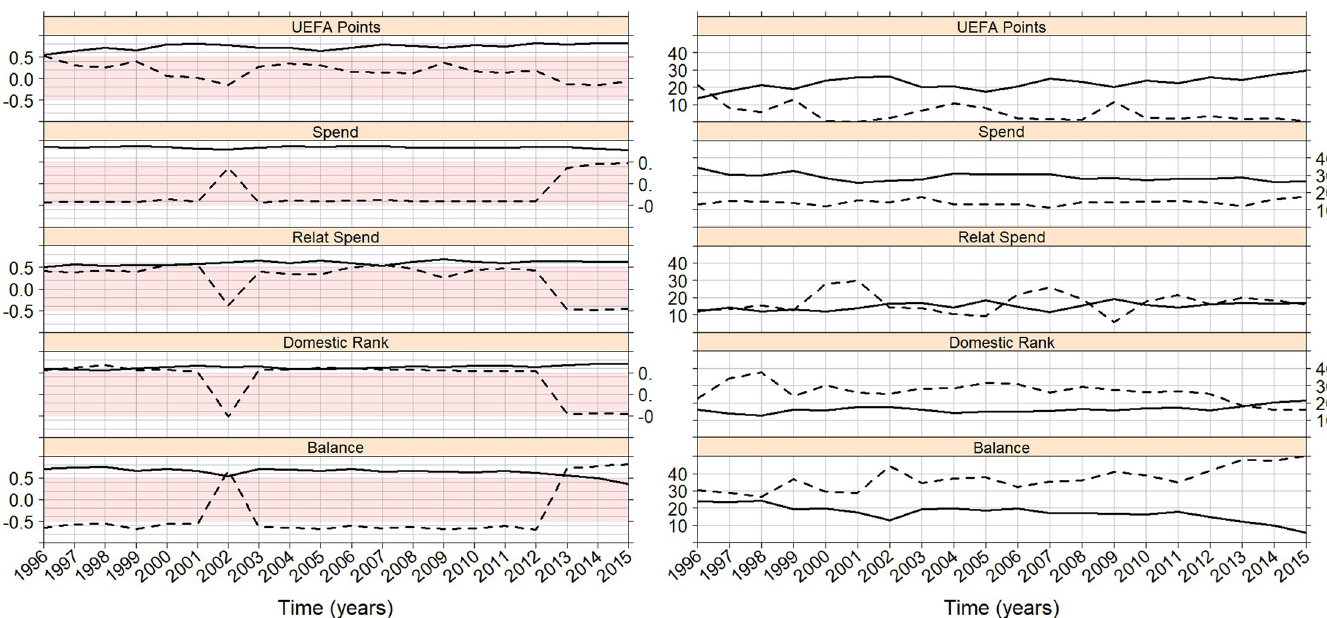
Fig 8. Principal Component Analysis. Correlations of the five variables with the first (solid lines) and second (dashed lines) component displayed in the left panel. The right panel shows the percentage of variance of each variable for the first (solid lines) and the second (dashed lines) components. Years in the x-labels correspond to the first year of the season (i.e. 1996 for 1996–1997